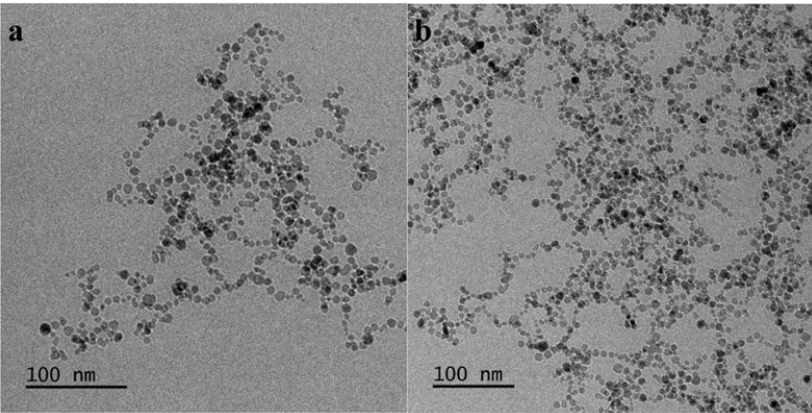
Figure 12. Cryo-TEM micrographs ( a , b ) of the magnetopolyplexes at N / P = 4.